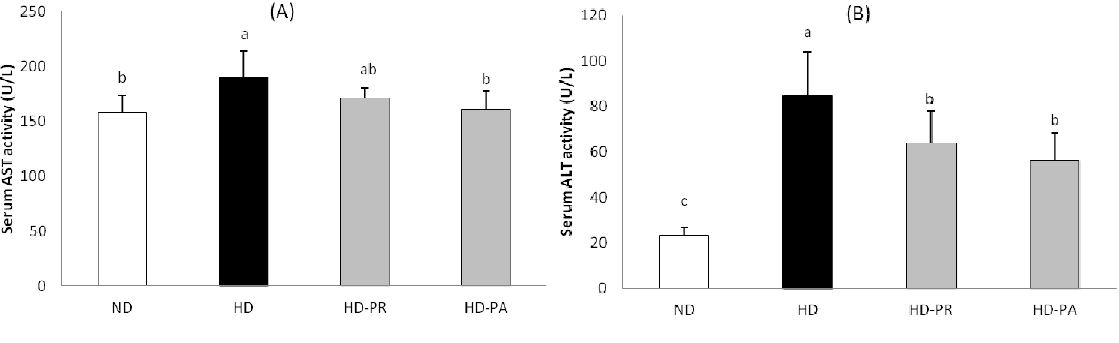
Figure 3. ( A ) Serum aspartate aminotransferase and ( B ) alanine aminotransferase levels. Bars represent the mean ± SEM, n = 5 mice per group. Values with different superscripts are significantly different ( p < 0.05) as assessed by one-way ANOVA and the Duncan’s multiple range